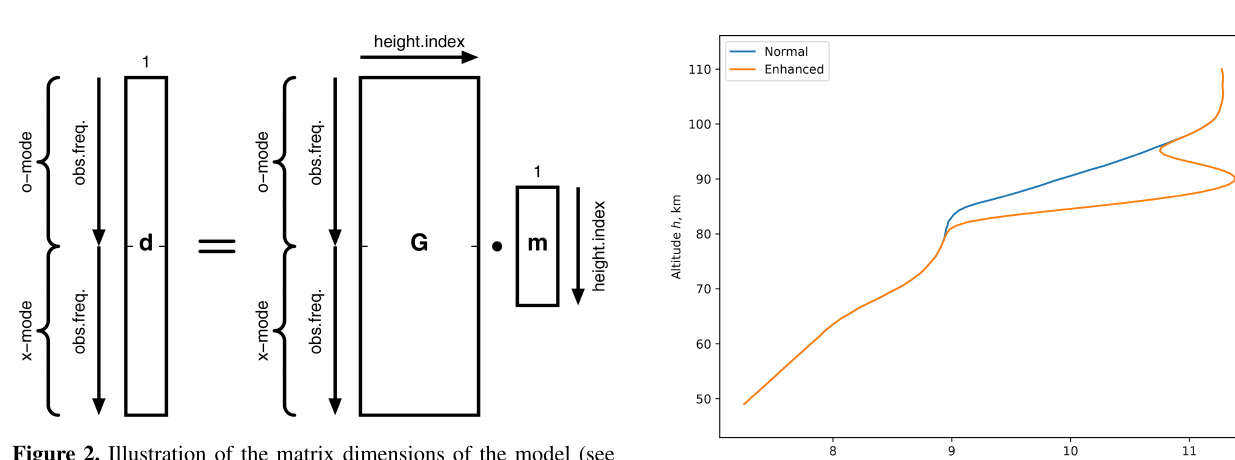
Figure 2. Illustration of the matrix dimensions of the model (see Eq. 6).